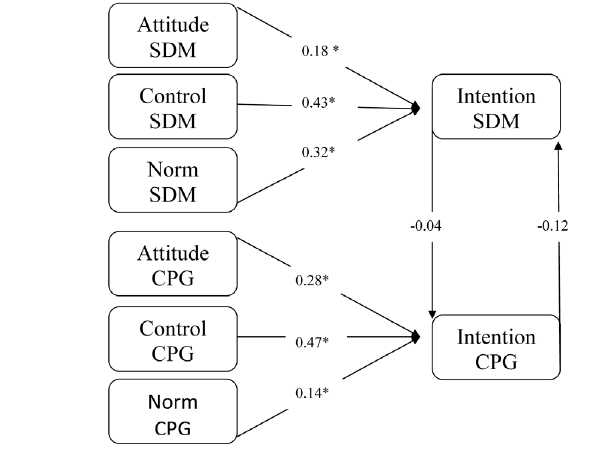
Figure 2. Standardized path analysis coefficients for experi- mental group at study entry, showing attitude, perceived behavioral control and subjective norm as predictors of physicians’ behavioral intentions to engage in SDM and to follow CPGs; and showing the influence of the intention to engage in SDM on the intention to follow CPGs and vice versa (vertical arrows).